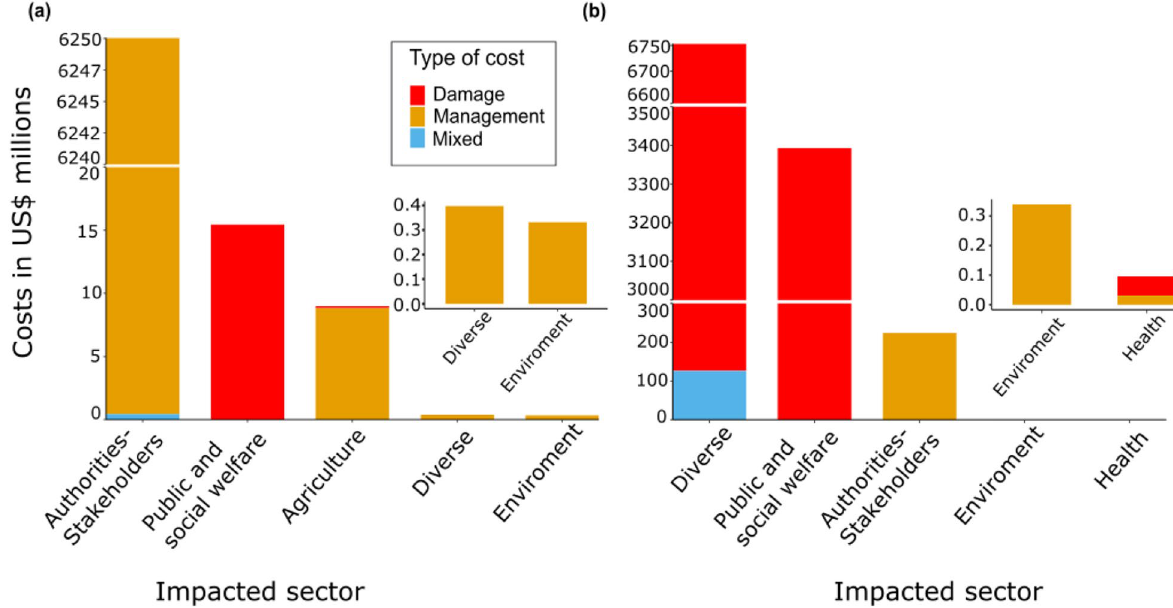
Figure 3. Total cost of alien ( a ) amphibian and ( b ) reptile species according to the sector impacted and their type of